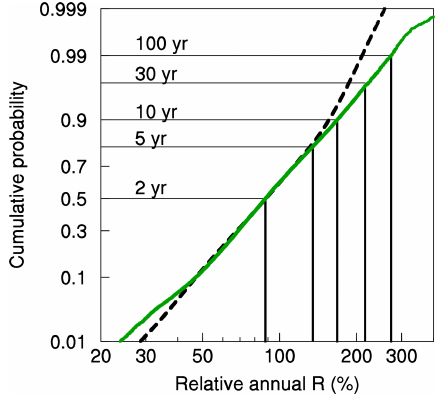
Figure 4. Cumulative distribution curve of the annual R factor rel- ative to the long-term mean R factor of a pixel. Dashed black line applies for erosivities derived from 1h data for the whole of Ger- many and 17 years ( n = 7 . 7 million). Solid green line applies for erosivities derived from 5min data for the test region and 2 years ( n = 24770). Straight vertical and horizontal lines indicate return periods between 2 and 100 years. The y axis is probability scaled; the x axis is log